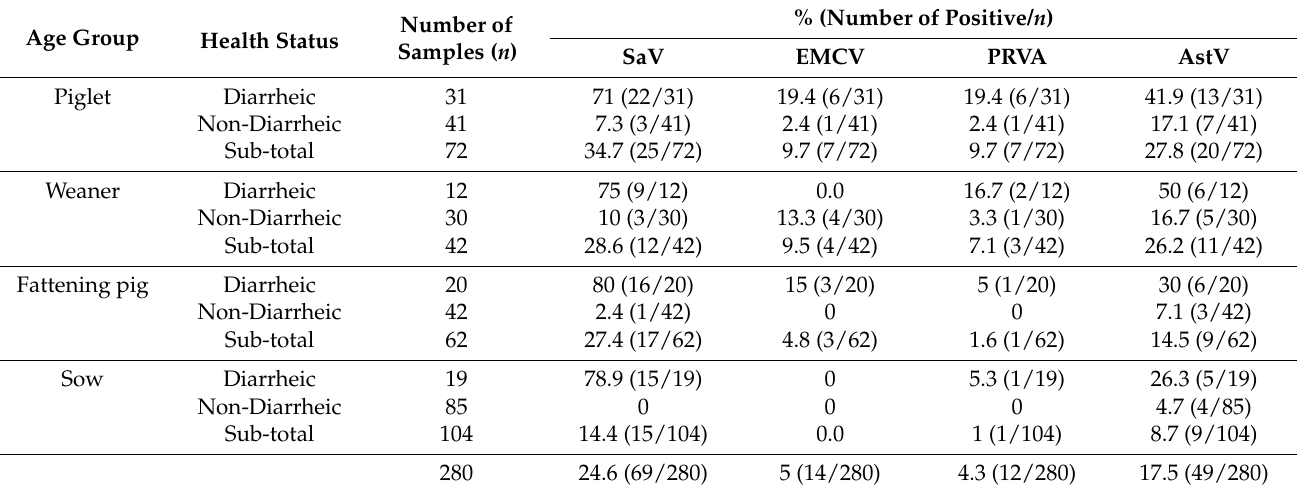
Table 2. Prevalence of AstV, EMCV, RVA and SaV.